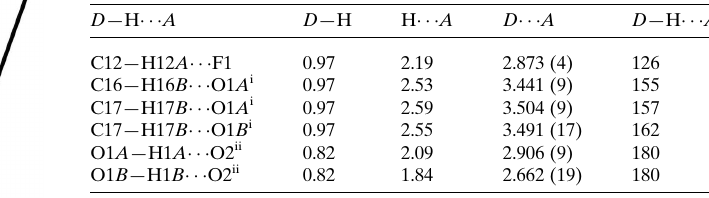
Table 1 Hydrogen-bond geometry (A˚ , (cid:3) ).